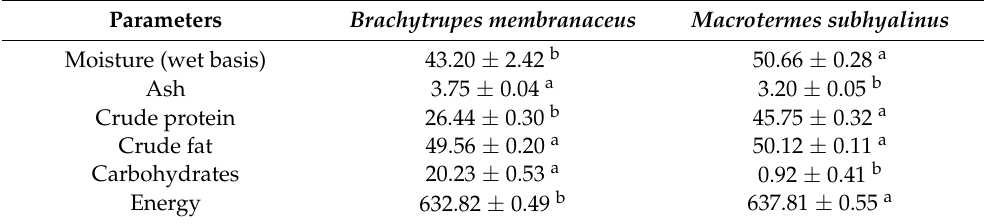
Table 1. Proximate composition on a dry basis (g/100 g) and energy (Kcal/100 g) of Brachytrupes membranaceus and Macrotermes